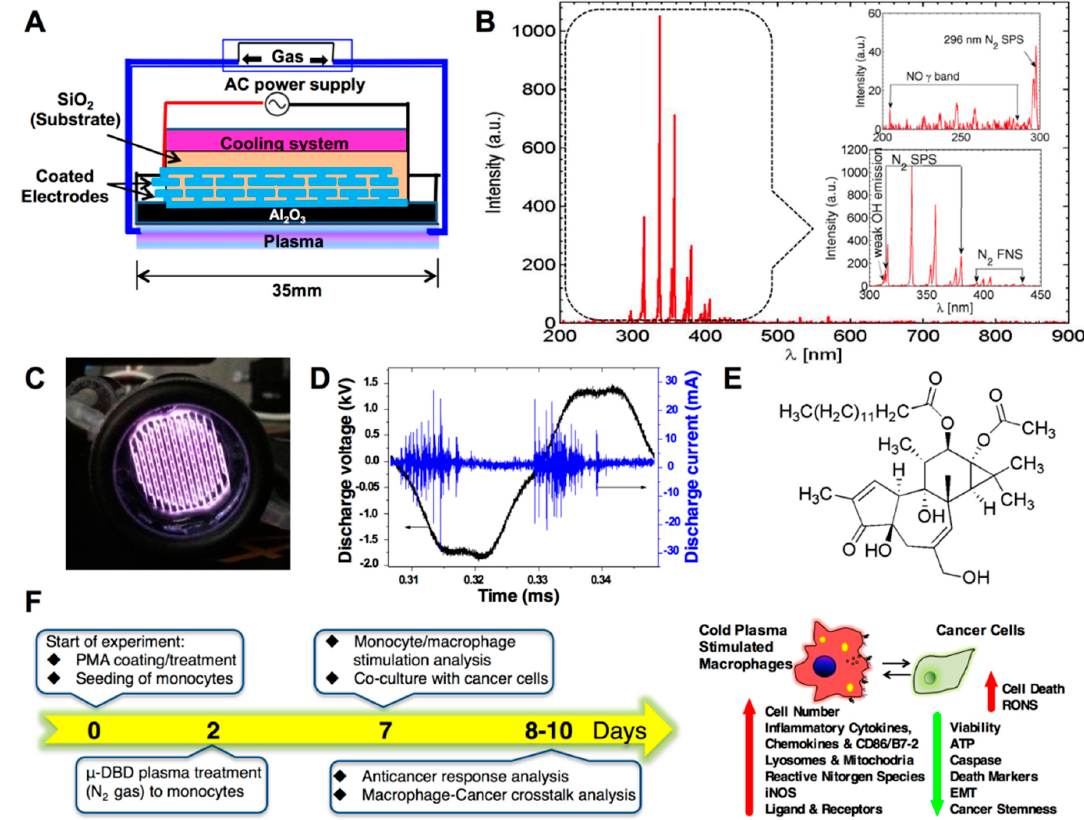
Figure 1. Cold µ-dielectric barrier discharge (DBD) nitrogen plasma configuration, characteristics and treatment conditions. ( A ) Schematic diagram of the µ-DBD nitrogen plasma device for biomedical applications. ( B ) Optical emission spectroscopy (OES) spectra of the µ-DBD nitrogen plasma device. ( C ) Live image of the µ-DBD nitrogen plasma device during treatment. ( D ) The voltage and current profiles of the µ-DBD nitrogen plasma device. ( E ) The structure of phorbol-12-myristate-13-acetate (PMA). ( F ) Experimental scheme for the cancer cells co-cultured with PMA-differentiated plasma stimulated macrophages. Different analysis patterns will be performed in both cancer cells and macrophages as mentioned in the right panel.